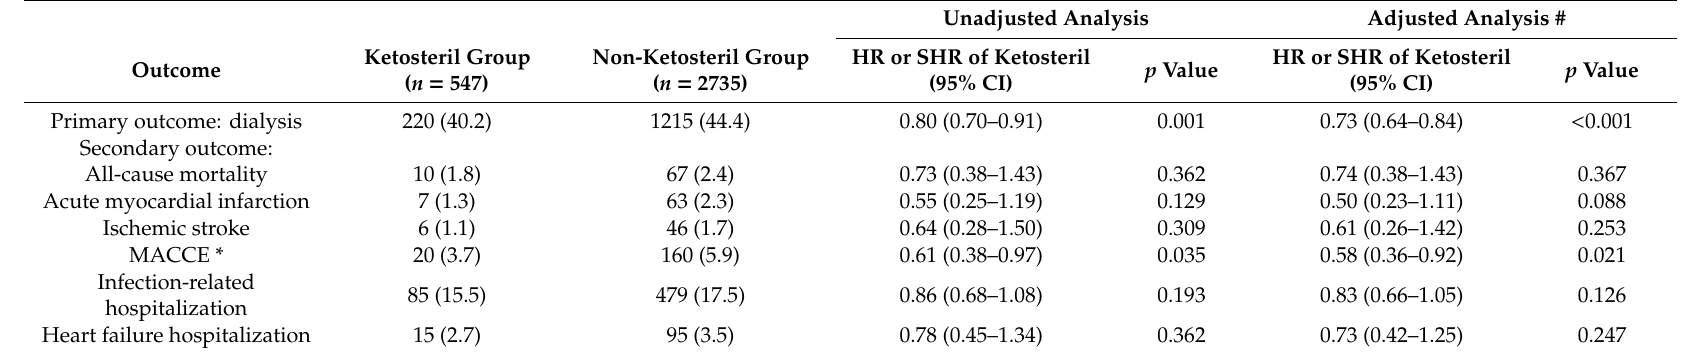
Table 2. Clinical outcomes at 1 year of patients with advanced CKD in the Ketosteril and non-Ketosteril groups. Unadjusted Analysis Adjusted Analysis